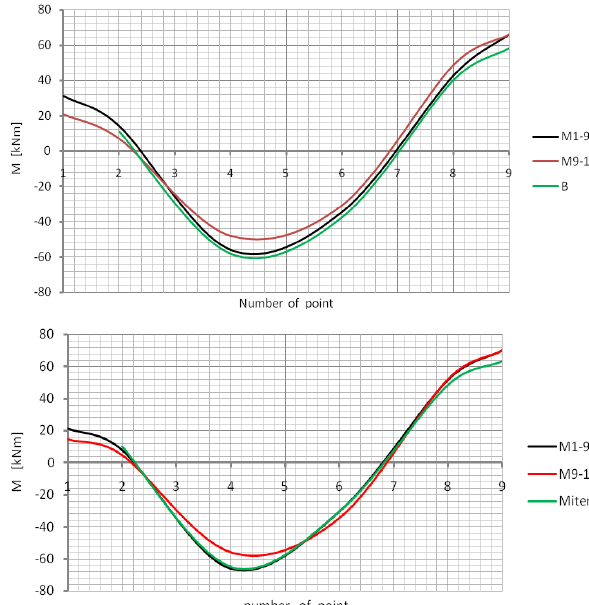
Figure 11: Comparison of bending moments for the purpose of evaluating effectiveness of the algorithm.